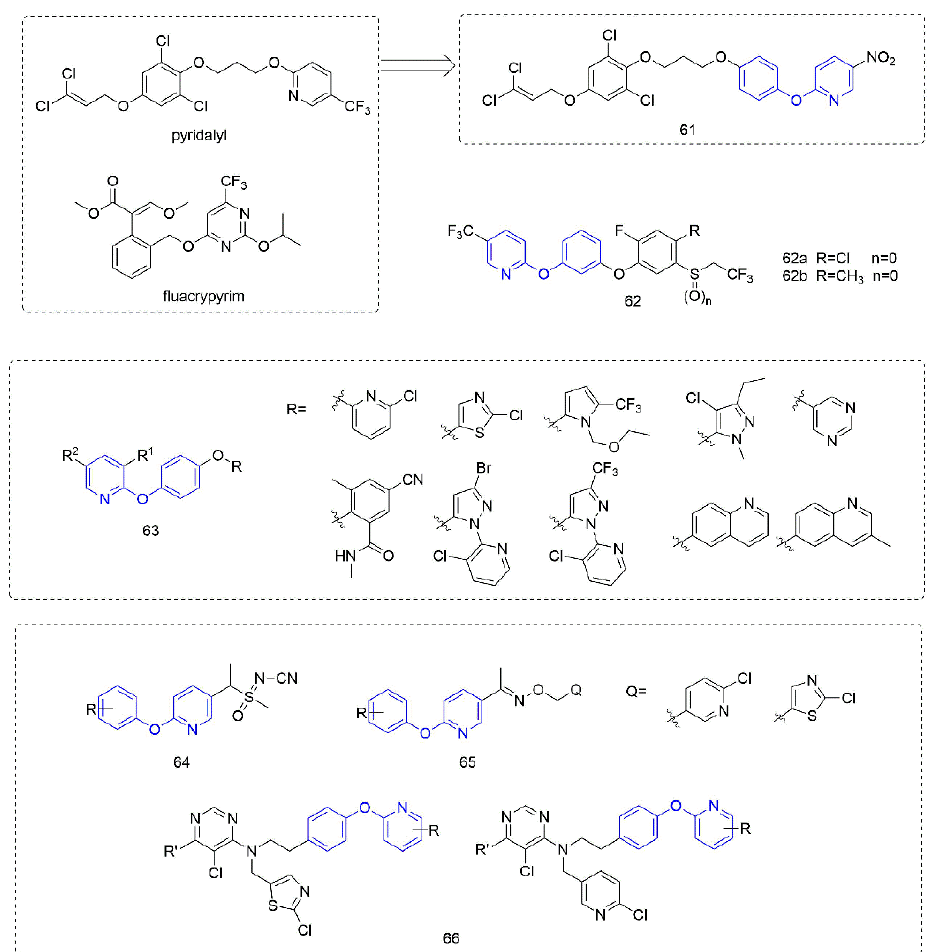
Figure 14. Other compounds with insecticidal activity containing